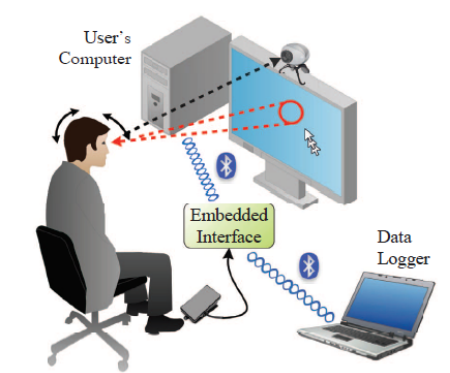
Figura 6. FHCI contextual architecture. Source: Antunes et al. (2016). STTK (Speech-To-Text plus Kinect), is a multi-modal Na- tural User Interface (NUI) (Salnikov et al., 2014). It aims to improve computer access experience for users with motor disabilities in the upper limbs. The solution combines two types of data input: gestures and voice using STT (Speech- To-Text), TTS (Text-To-Speech) technologies, and gesture recognition.